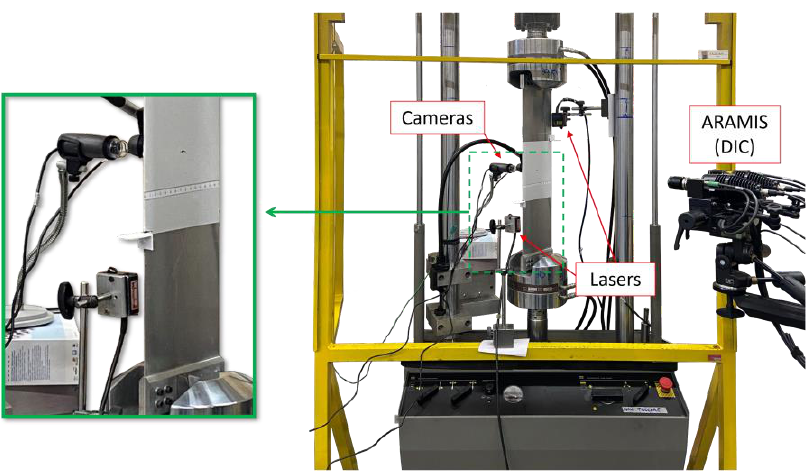
Figure 9. Test rig with the main acquisition systems.